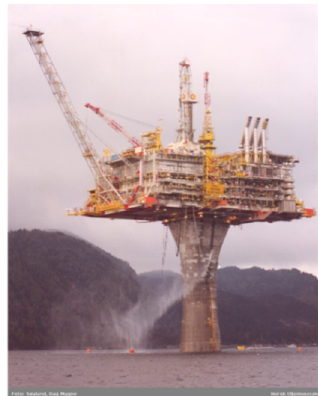
Figure 1. The Draugen platform ready to be towed to site in 1993. Note the slender concrete shaft and the widening at the top to support the topside facilities.